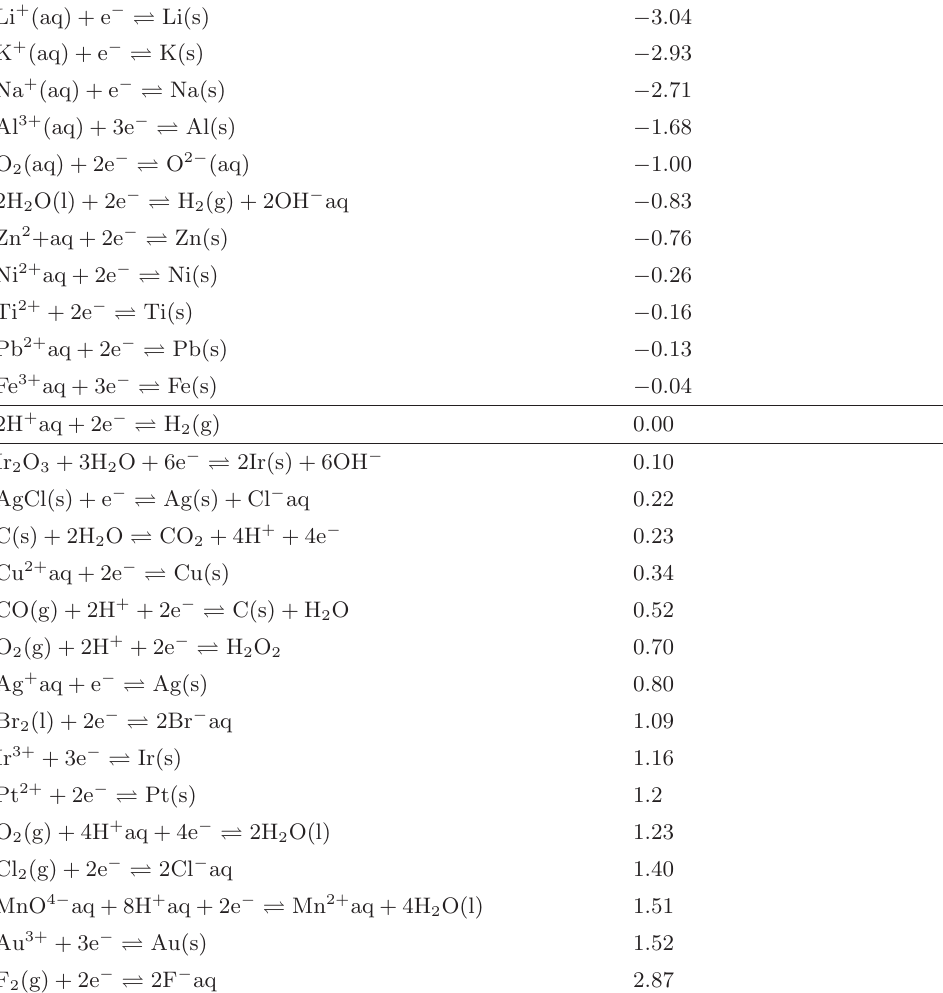
Table I. – This table provides E 0 values for selected reduction reactions. Values have been taken from [21,22]